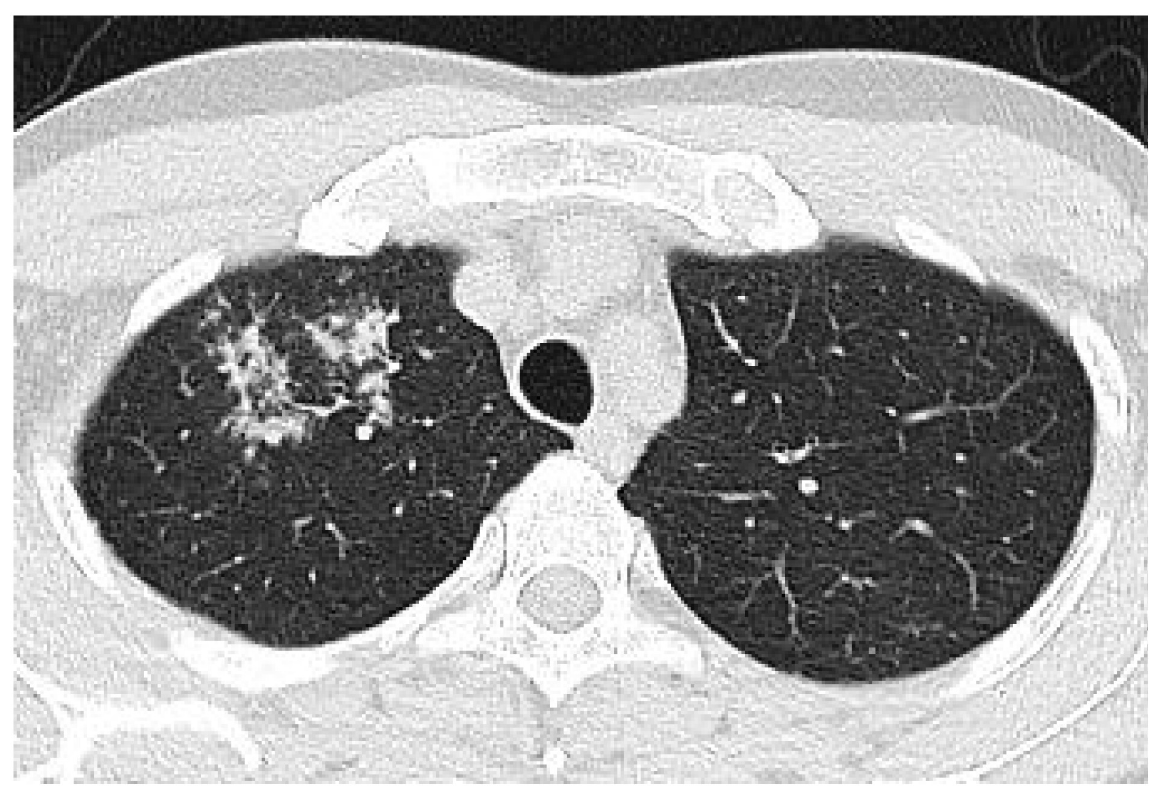
after positive Xpert MTB/RIF assay on bronchoalveolar